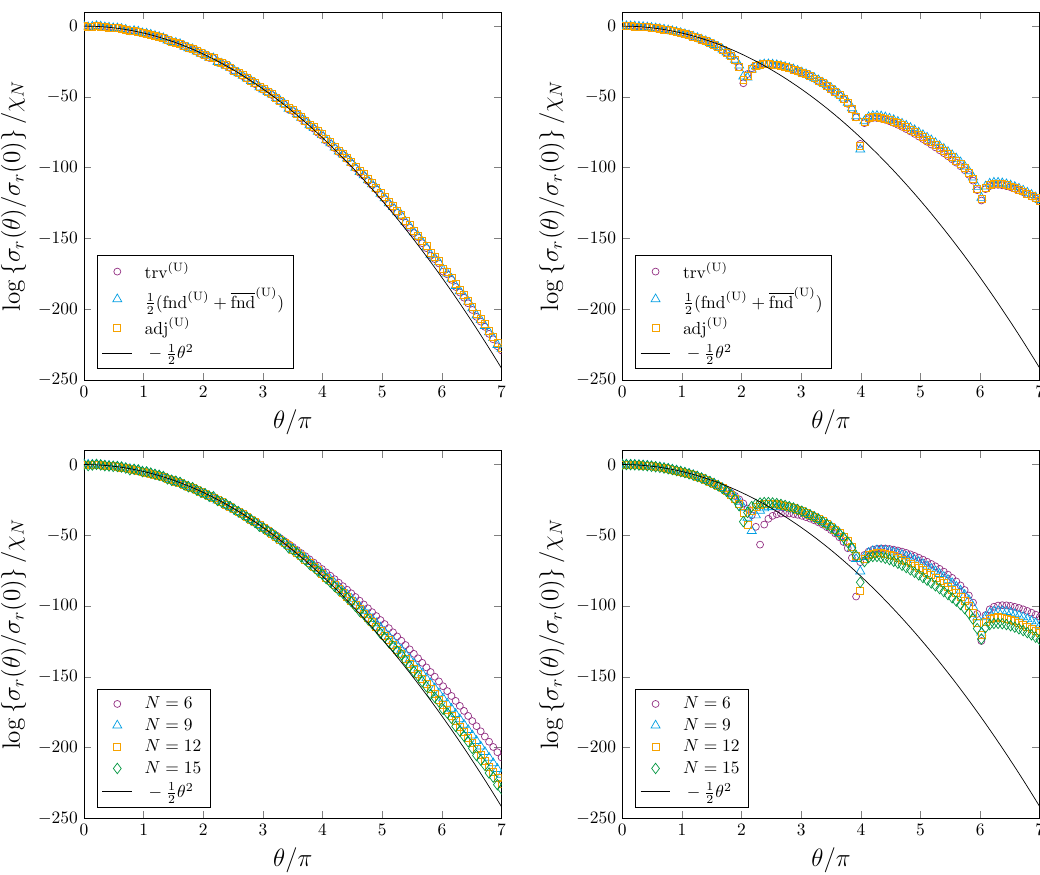
Figure 17 . (Top) The quantity 1 log { σ r ( θ ) /σ r (0) } is plotted against θ for the trivial, fundamental χ N and adjoint representations in the U( N ) gauge theory with N = 15 at λ = 1 . 5 (Left) and λ = 3 (Right). We also show the behavior − 1 θ 2 by the solid lines for comparison. (Bottom) The same 2 plots with various N at λ = 1 . 5 (Left) and λ = 3 (Right) are shown for the trivial representation. A clear large- N scaling behavior is seen. Similar behaviors are observed for the other